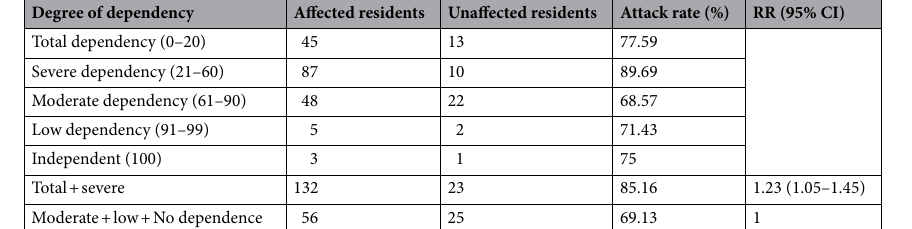
Table 2. Degree of dependency (Barthel index) in affected and unaffected residents, attack rates and rate ratio (RR) in residents with total or severe dependence versus residents with moderate, low or